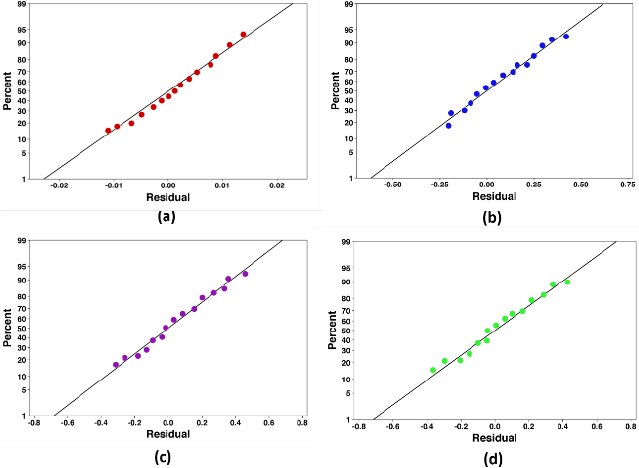
Figure 7. Normal probability plot of the residuals for the pumping power, ( a ): ϕ = 0%, ( b ): ϕ = 1%, ( c ): ϕ = 3%, and ( d ): ϕ = 5%. Table 8. The percentage of the adjusted coefficient of determination for each response.